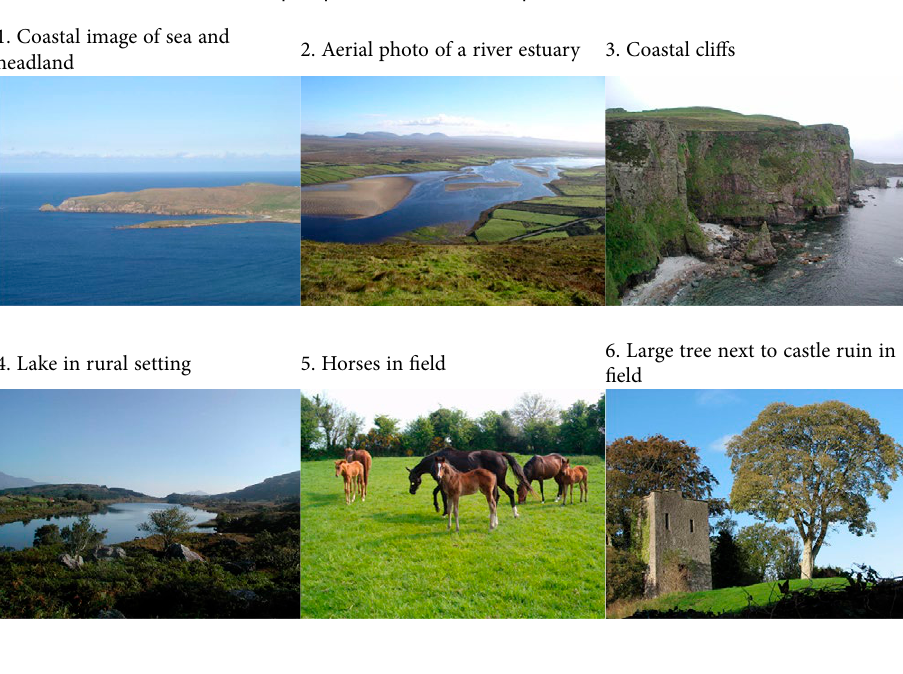
Table 3. Least Preferred Landscapes (photo numbers correspond to ranks in Table A1). 50. Flooded